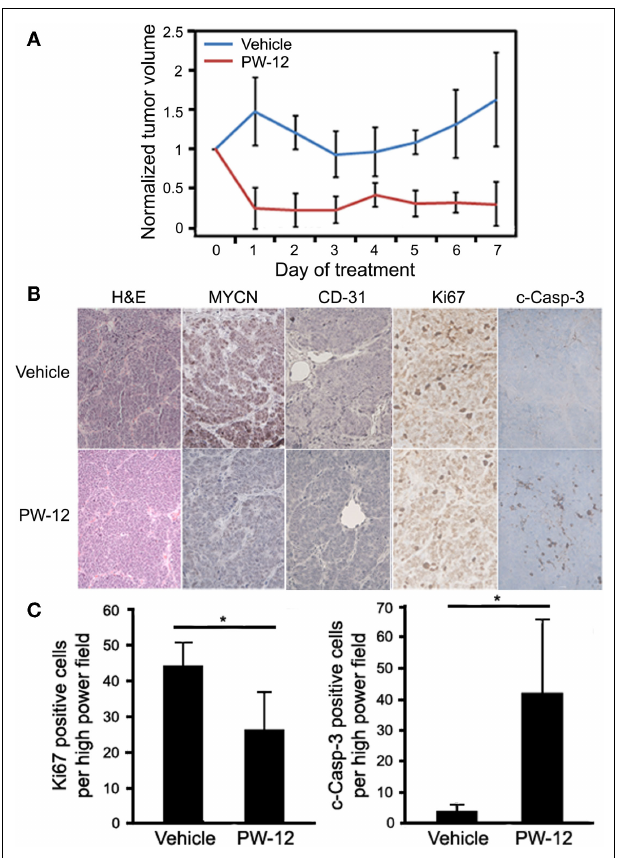
FIGURE 3 | PW-12 is efficacious in an orthotopic flank tumor model of MYCN-amplified medulloblastoma . Mice were implanted with 6 (cid:2) 10 6 SmoWT medulloblastoma cells in the hindflank. Animals were treated for 7days with 25mg/kg of PW-12 ( n = 5) or vehicle alone ( n = 5). (A) Tumor size was significantly reduced in treated animals (all time points days 1–7 resulted in statistically significant differences between the treatment and control groups). (B) Histology on H&E stain is consistent with medulloblastoma (H&E, 20 (cid:2) ). Tumor cell proliferation (Ki67, 40 (cid:2) ) was decreased, apoptosis (cleaved-caspase-3, 40 (cid:2) ) increased, MYCN (20 (cid:2) ) expression downregulated, and vascularity decreased in PW-12 treated tumors as confirmed by histology (B) and cell quantification for apoptosis and cell proliferation (C) . (* represents p < 0.05).